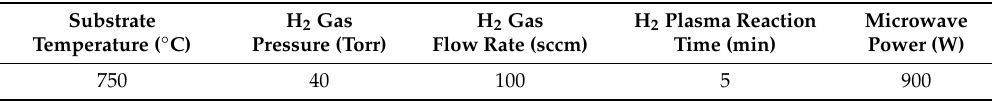
Table 1. Experimental conditions for H 2 plasma treatment using the microwave plasma-enhanced chemical vapor deposition (MPECVD)